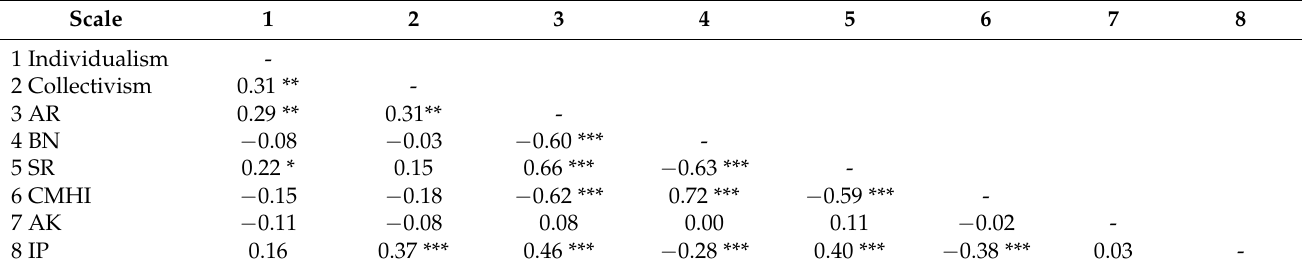
Table 3. Bivariate Correlations between Horizontal and Vertical Individualism–Collectivism (HVIC), Community Attitudes toward the Mentally Ill (CAMI), and Perceptions of Mental Illness (POMI) Subscales ( N =